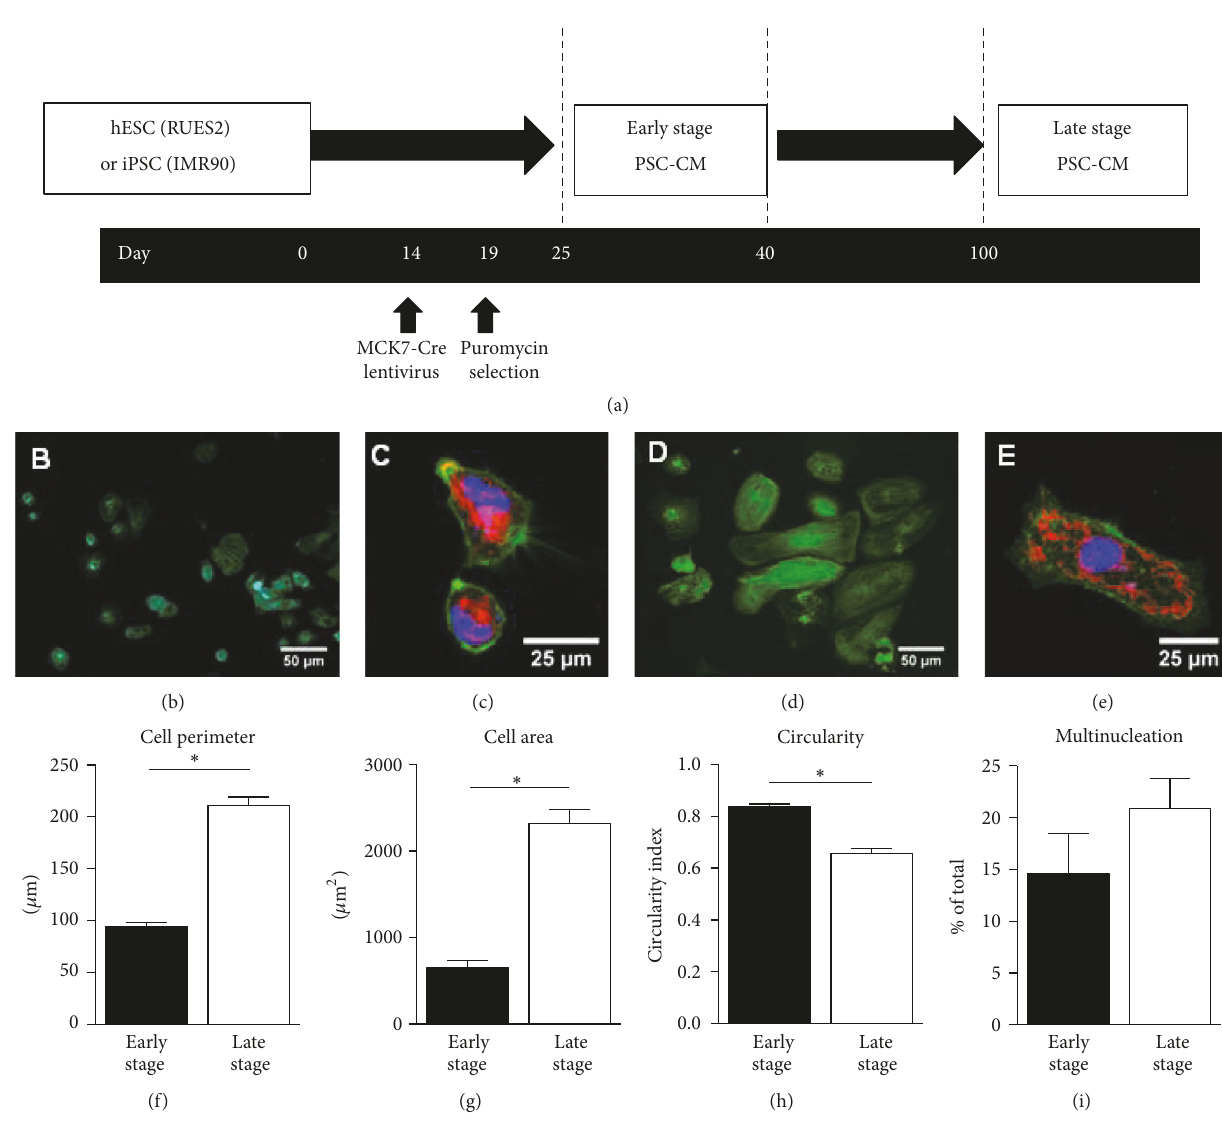
Figure 1: (a) Differentiation and maturation scheme for early and late stage human ESC-CMs (RuES2) and iPSC-CM (IMR90). hESCs were maintained in a mouse embryonic fibroblast-conditioned medium (MEF-CM) supplemented with fibroblast growth factor (FGF). iPSCs were maintained in mTeSR. Both RuES2 and IMR90 stem cells were differentiated into CMs (day 0) by serial treatment with activin A and BMP-4. On day 14, hESC-CMs were transduced with MCK7-Cre lentivirus during replating onto PEI-gelatin coated glass coverslips/plastic plates. On day 19 cells were replated a second time in the presence of 2ug/mL puromycin and selected for 48 hours. Cells were maintained for approximately 3 months in culture. We classified cells between days 25 and 40 as early stage PSC-CMs and cells > day 100 as late stage PSC-CMs. Alpha-actinin immunofluorescence (b and d) and mitochondrial staining (red)/eGFP (green) (c and e) of early stage (b-c)